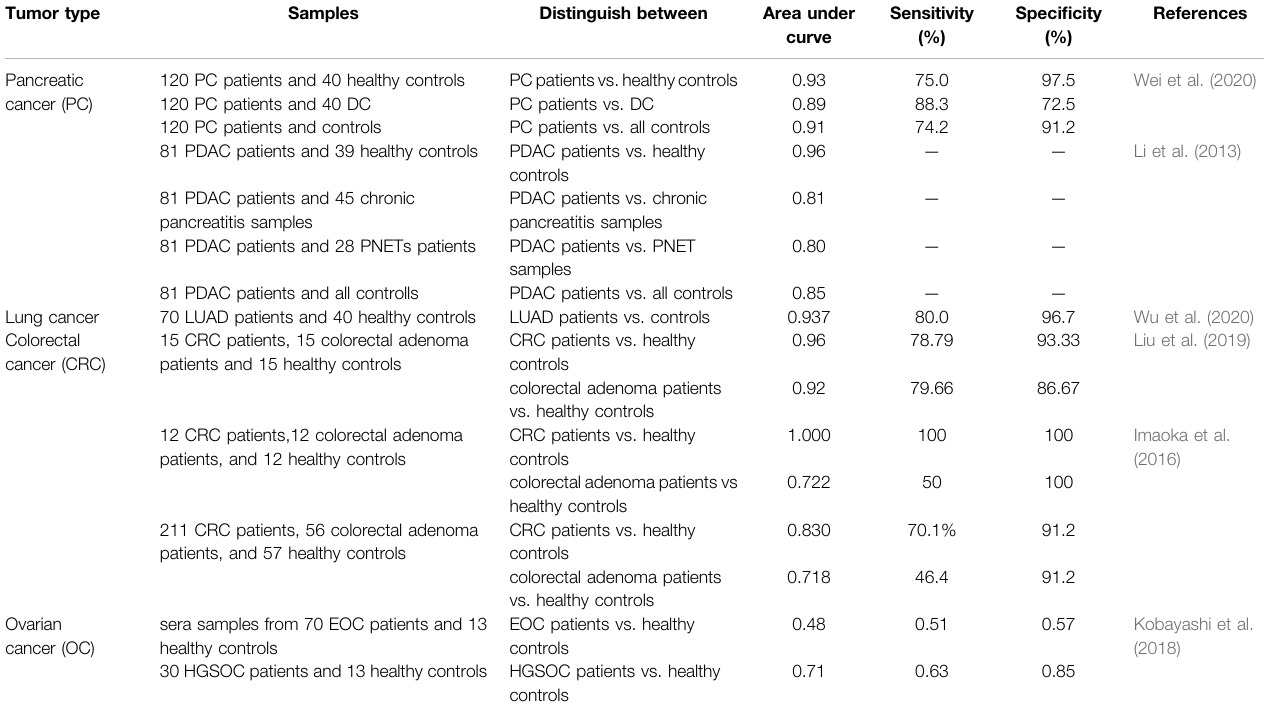
TABLE 4 | Diagnostic value of miR-1290 in cancers (PC: pancreatic cancer; DC: benign pancreatic disease control; LUAD: Lung adenocarcinoma, EOC: epithelial ovarian cancer, HGSOC: high grade serous ovarian carcinoma). Tumor